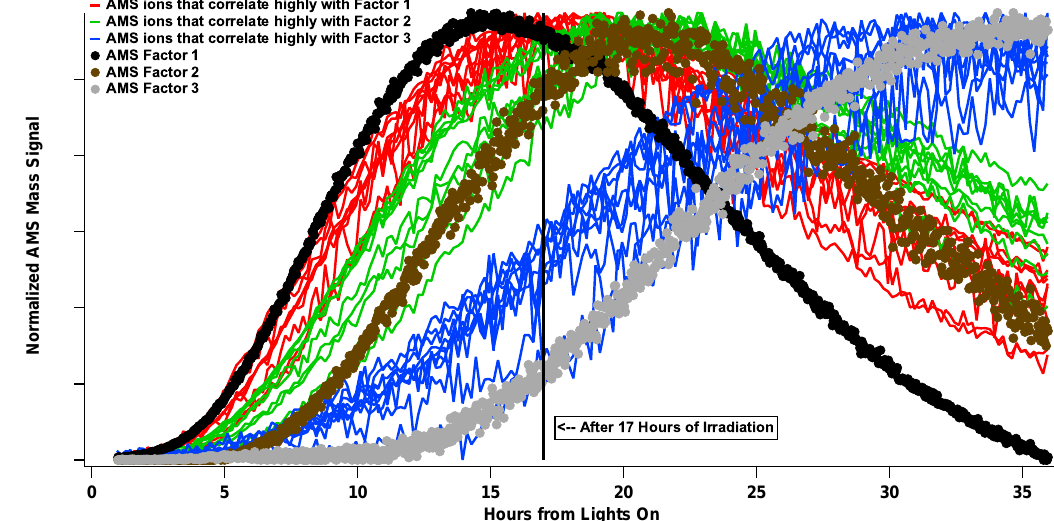
Fig. A1. Normalized mass signals from the AMS PMF factor time series are plotted with the AMS ions that have the highest correlations with those factors (ions listed in Table 3).